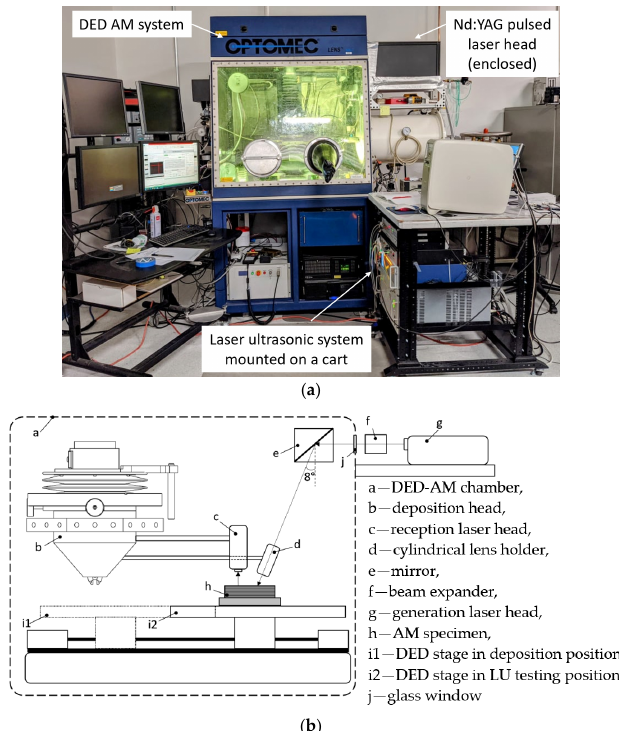
Figure 4. Laser ultrasound system integrated into DED-AM chamber: ( a ) photograph, ( b ) schematic. The laser interferometer (AIR-1550-TWM, Intelligent Optical Systems Inc., Torrance, CA, USA) detects the out-of-plane displacement u 3 at a point on the surface. Its adaptabil- ity to variable surface roughness and reflectivity makes it a critical component in the sys- tem. The reception laser head is mounted on an XY stage to enable scanning along the centerline of the nominally planar wavefield. In addition to the benefits of the two-wave mixing approach, the interferometer has two output signals – AC (alternating current) and DC (direct current). The AC signal contains the time-varying voltage proportional to the surface displacements, while the DC level provides a measure of the light reflected from the surface. Thus, normalizing the AC signal by the DC level provides a means to compare the signals obtained from surfaces with varying roughness and reflectivity. Ad- ditionally, the wave propagation distance is kept low to minimize the attenuation and diffraction effects and improve the signal-to-noise ratio (SNR). When scanning across the hatches, the scan increment is a multiple of the hatch spacing, such that the reception laser beam is focused on the top of each track, thereby maximizing the light collected by the reception laser head. As the build height increases the deposition head (part b in Figure 4) moves up, tak- ing the reception laser head (part c) and the cylindrical lens (part d) with it. For the rela- tively small build heights used here, there is no need to change the angle of the mirror (part e).